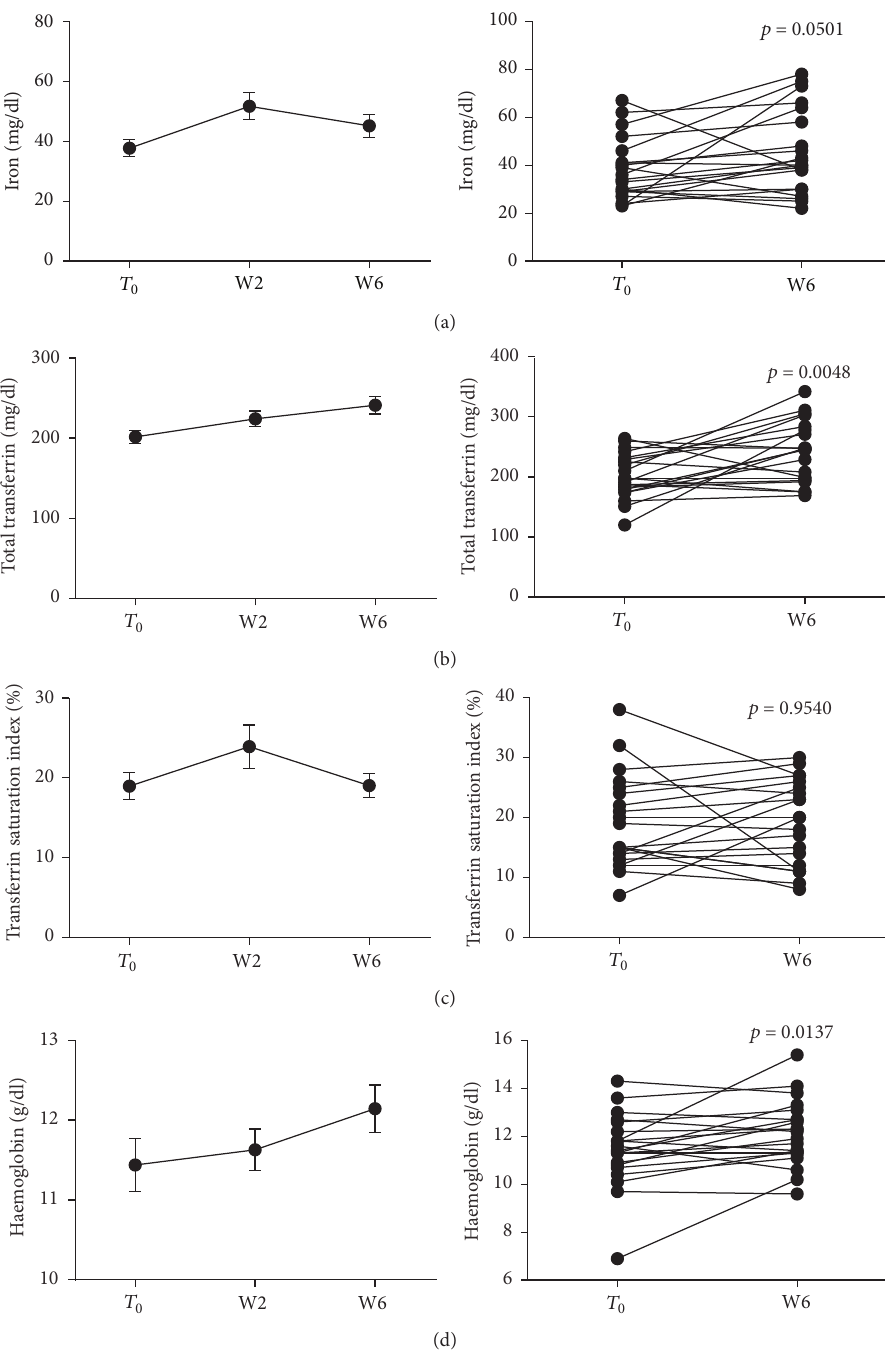
Figure 5: Modulation of iron markers and haemoglobin following anti-TNF therapy. Blood samples were collected before each anti-TNF administration( 𝑁 = 21 /timepoint)andcirculatingiron,transferrin,andhaemoglobinlevelsmeasured.Transferrinsaturationwascalculated, as well. Statistical analysis was performed using Student’s 𝑡 -test for paired data. Data are presented as single data point or as mean ±